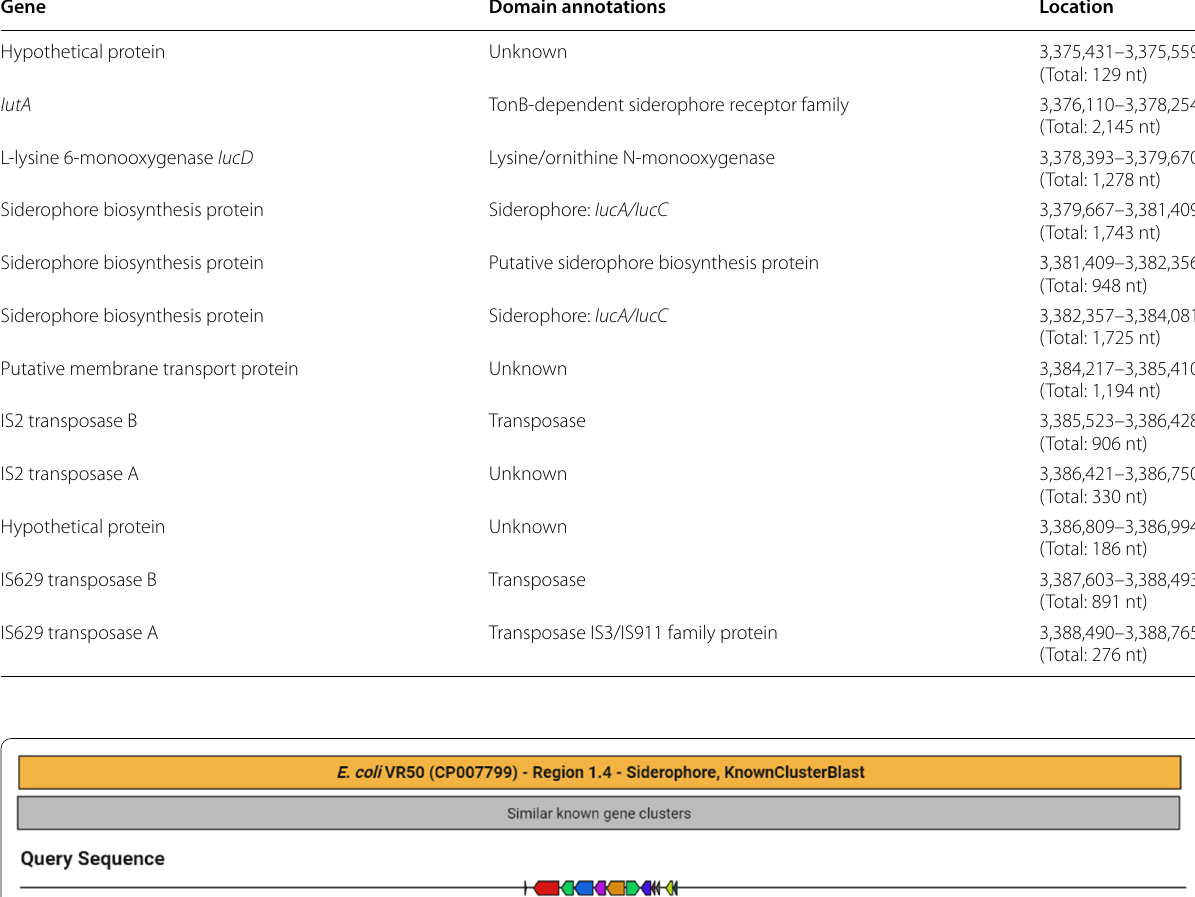
Table 3 The genes in the Region 1.4 of E. coli VR50 genome